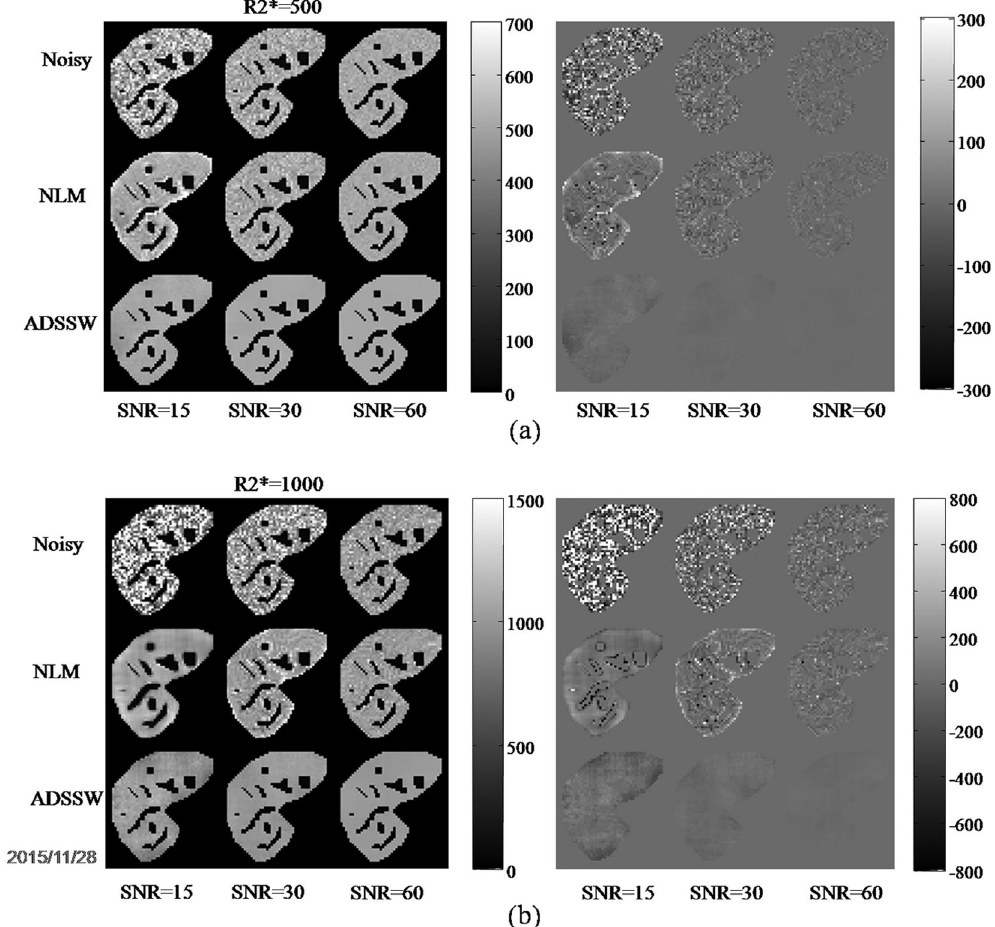
Figure 1. R2 * mappings fitted from the original, NLM-, and ADSSW-filtered simulated data for SNR = 15, 30 and 60 with two true liver R2 * values: ( a ) 500 s − 1 , ( b ) 1000 s − 1 . Left: the estimated R2 * mappings. Right: the corresponding R2 * error